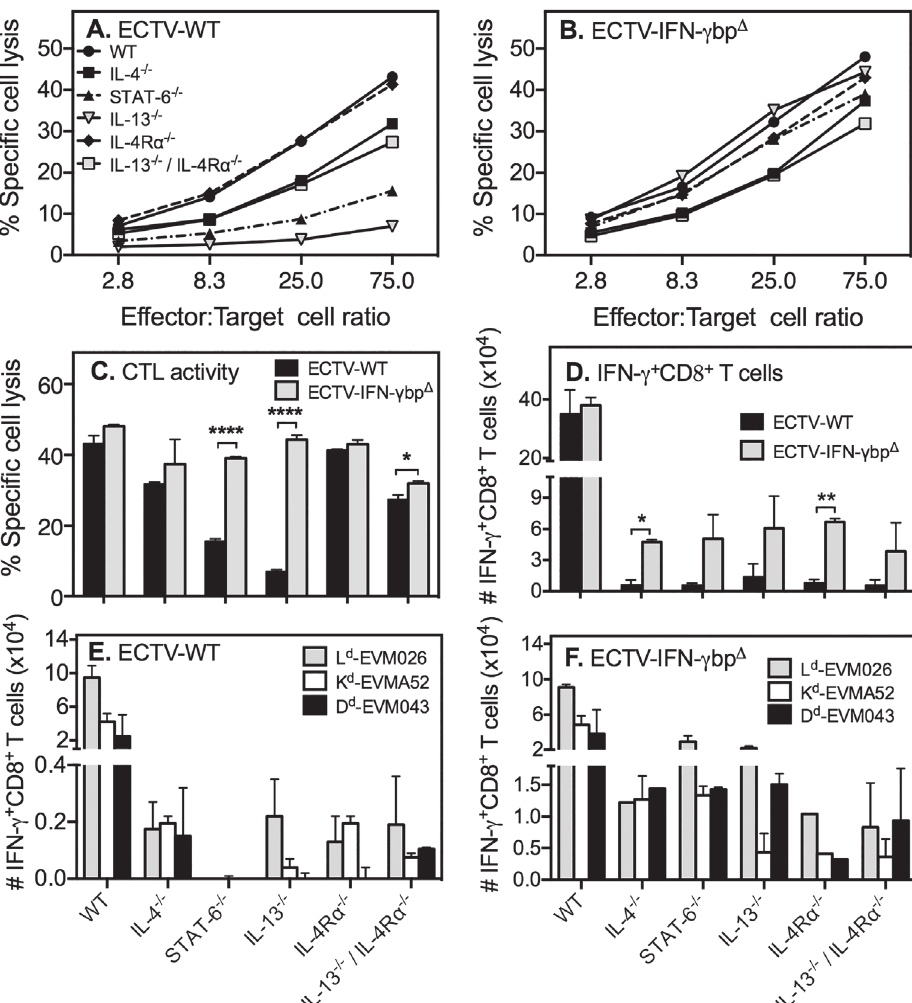
Fig 4. CD8 T cell responses to ECTV-WT and ECTV-IFN- γ bp Δ . Mice (n = 5 – 10/group) were infected with ECTV-WT or ECTV-IFN- γ bp and sacrificed 7 days later to measure splenic CTL activity. Shown is % specific lysis of 51 Cr-labelled, ECTV-infected P815 target cells by splenocytes from (A) ECTV-WT- or (B) ECTV-IFN- γ bp Δ -infected WT and GKO mice. (C) Percent specific lysis of targets by splenocytes at 75:1 effector-to- target ratio. Two-way ANOVA followed by Fisher ’ s LSD test for significance was used for statistical analysis: (i) CTL response to ECTV-WT vs. ECTV-IFN- γ bp Δ in IL-13 − / − (p < 0.0001) and STAT-6 − / − (p < 0.0001) (ii) CTL response to ECTV-WT in WT vs IL-4 − / − (p = 0.0083), vs STAT-6 − / − (p = 0.0003), vs IL-13 − / − (p = 0.0001), vs IL-13 − / − /IL-4R α − / − (p = 0.0037) mice; (iii) CTL response to ECTV-IFN- γ bp in WT vs STAT-6 − / − (p = 0.0002); vs IL-13 − / − (p = 0.0478); vs IL-4R α − / − (p = 0.0174) and IL-13 − / − /IL-4R α − / − (p = 0.000046) mice. **** , p < 0.0001. (D — F) Spleen cells from mice infected mice were re-stimulated for 5 h with ECTV-infected P815 cells or H-2 d 8 T cell peptide determinants prior to intracellular IFN- γ staining followed by flow cytometry. Data shown are means of absolute numbers of ECTV-specific IFN- γ + 8 T cells in spleens of ECTV-WT- vs. ECTV- IFN- γ bp Δ -infected mice (D) and determinant-specific IFN- γ + 8 T cells following infection with ECTV-WT (E) or ECTV-IFN- γ bp (F) viruses. Two-way ANOVA followed by Fisher ’ s LSD test for significance was used for statistical analysis. For panels D, E and F, IFN- γ + 8 T cell numbers in WT mice were significantly higher (p < 0.0001) than numbers in all GKO strains. Data shown for D-F are representative of one of three independent experiments with similar results. * , p < 0.05; ** , p < 0.01; *** , p <